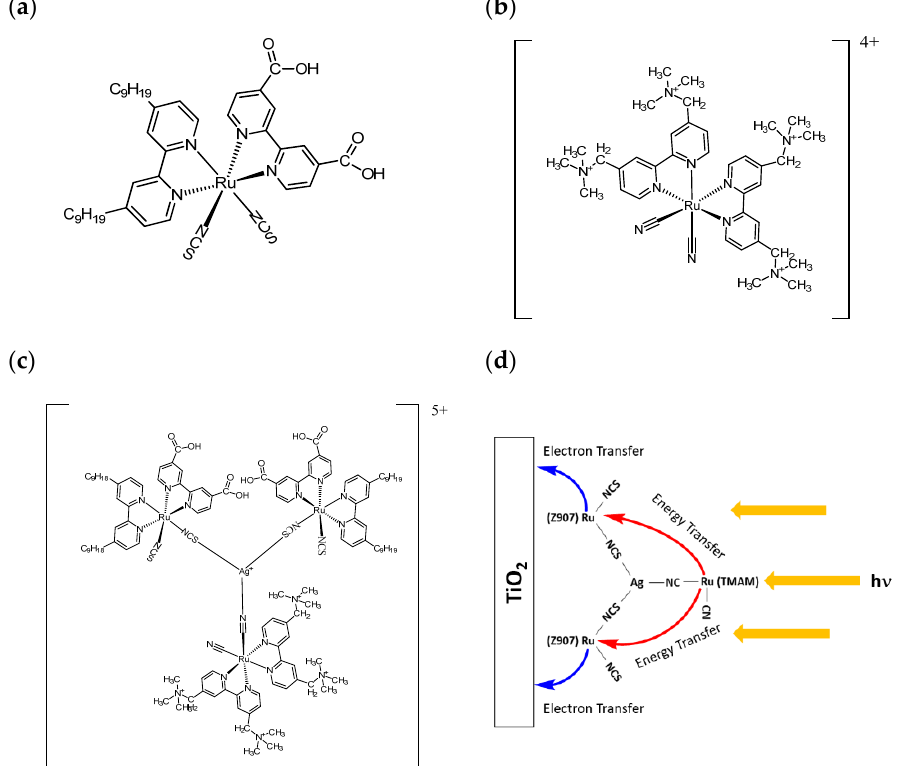
Figure 1. Schematic structure of: ( a ) Z907 , ( b ) 1 (Ru(TMAM)), ( c ) 4 (2Z907-Ag + -(Ru(TMAM))); ( d ) energy transfer (red lines) and electron transfer (blue lines) processes involved in n-type sensitiza- tion.